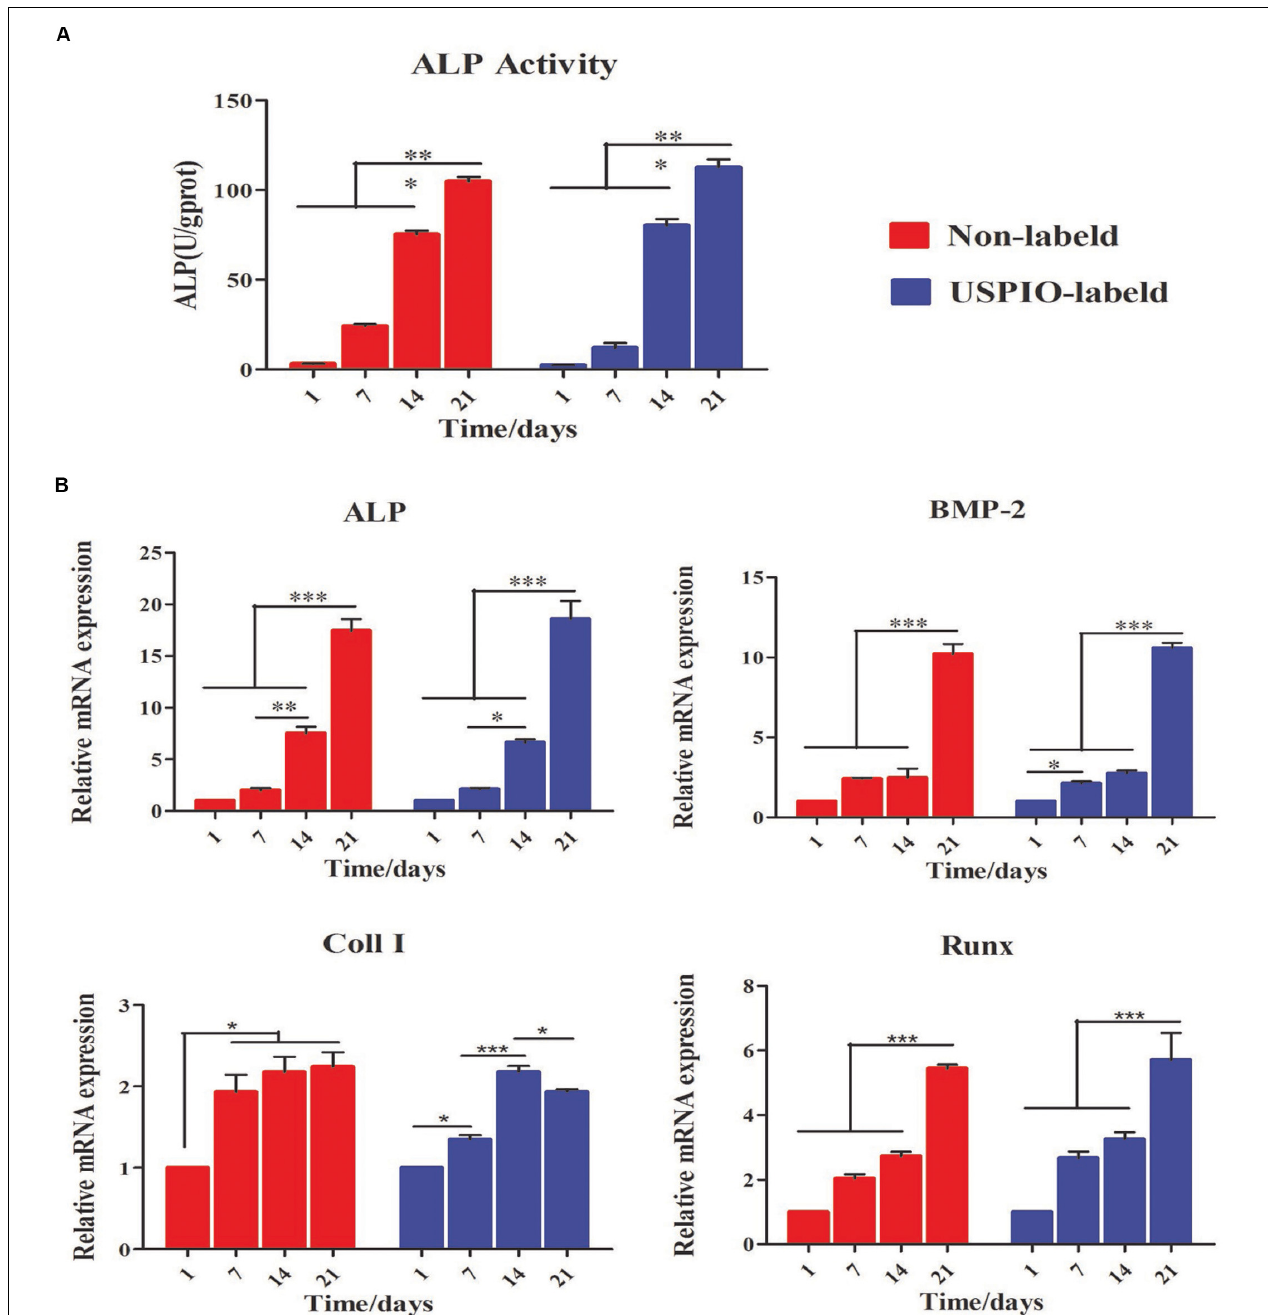
FIGURE 5 | Evaluation of osteogenic differentiation for BMSCs/scaffold composites. (A) ALP activity increases for both groups at 1, 7, 14 and 21 days. (B) Expression of osteogenic genes (Alp, Bmp-2, Coll I, and Runx) for BMSCs loaded on scaffolds is up-regulated over time (* P < 0.05, ** P < 0.01, or *** P < 0.001).